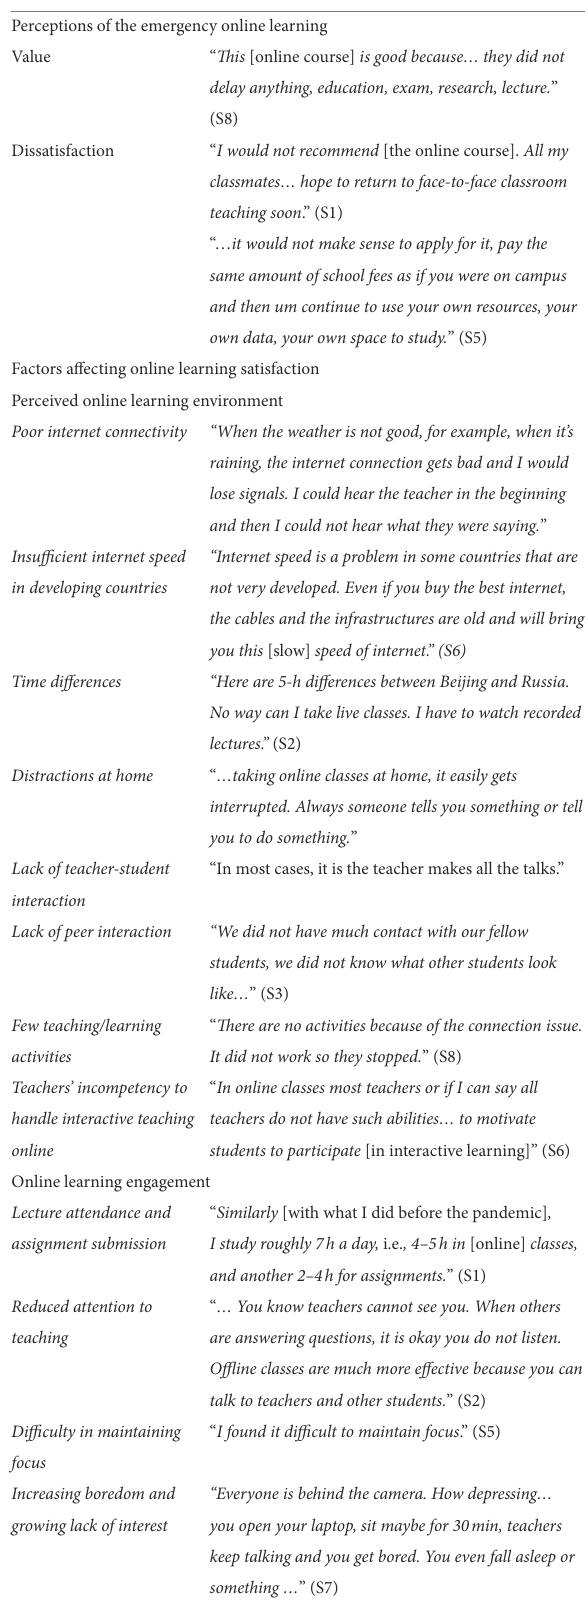
TABLE 3 Interview themes and representative